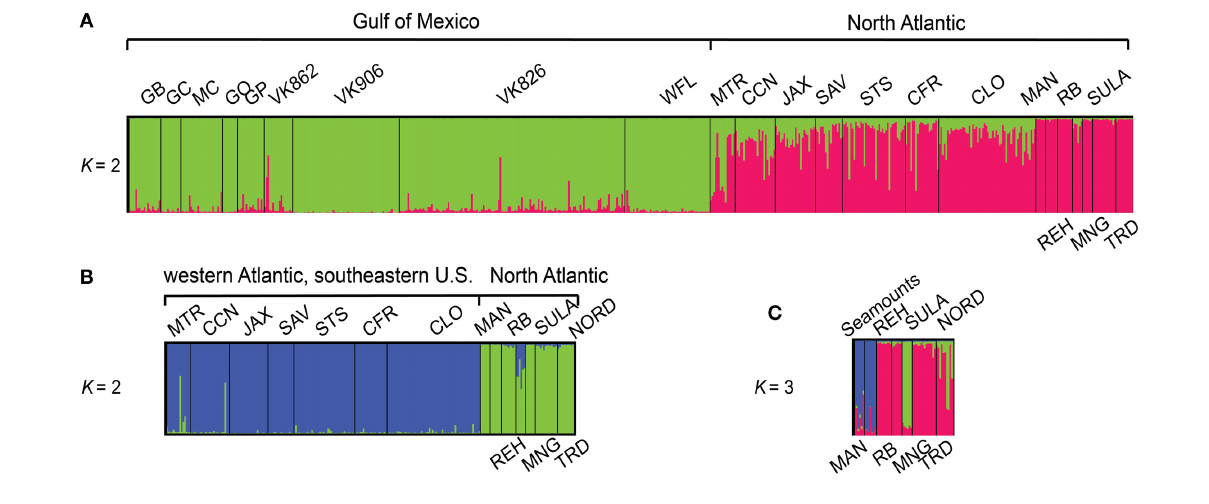
sorted West to East (A) . The North Atlantic cluster contained two additional levels of structuring detected in subsequent STRUCTURE analyses (B,C) . Site abbreviations and additional information are provided in Table